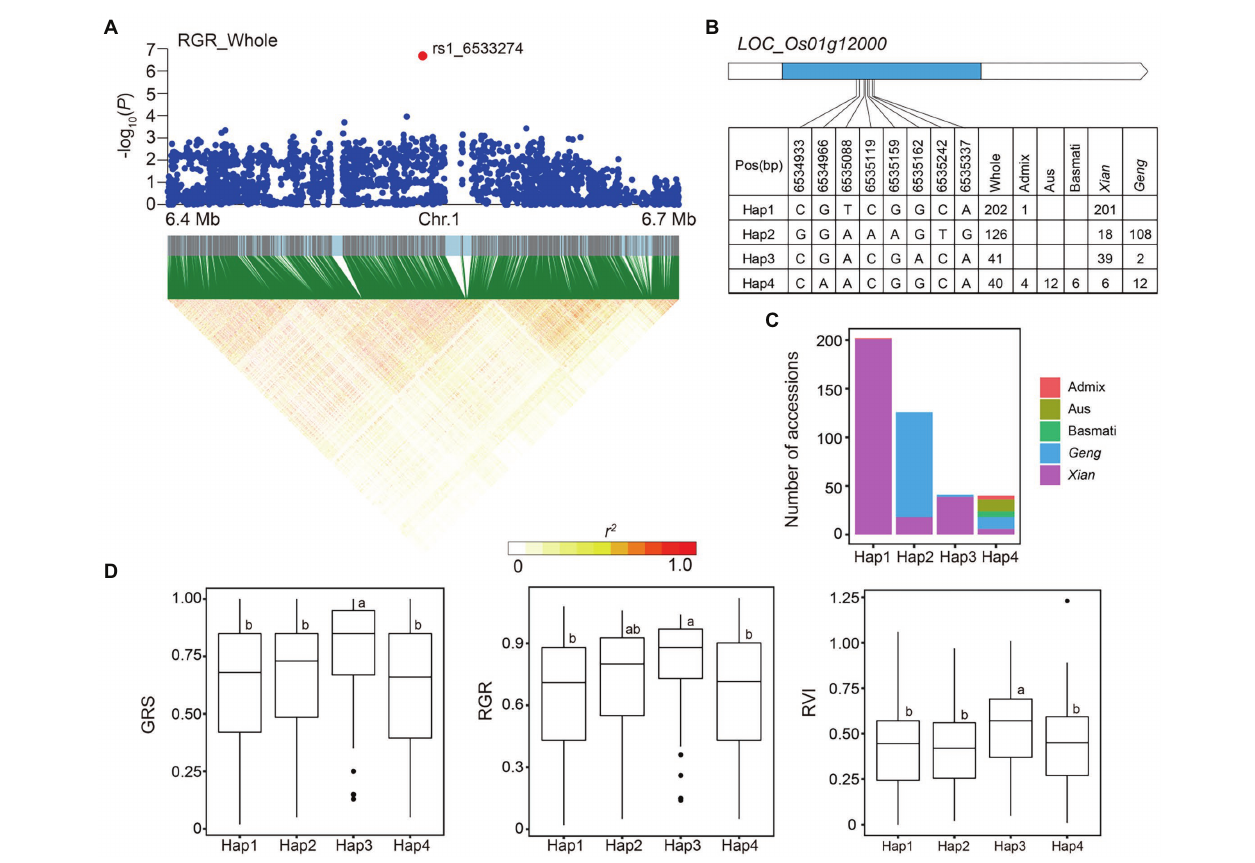
FIGURE 6 | Candidate gene analysis of locus 7 on chromosome 1. (A) Local Manhattan plot (top) and LD heat map (bottom) of locus 7 for RGR in the whole population. The red dot indicates the lead SNP rs1_6533274 and the position of candidate gene LOC_Os01g12000 . (B) CDS-haplotypes of LOC_Os01g12000 . (C) Frequency of four haplotypes of LOC_Os01g12000 in subpopulations. (D) The distribution of GRS, RGR, and RVI in the whole population for the four haplotypes of LOC_Os01g12000 . Different letters above each boxplot indicate significant differences among haplotypes according to Duncan’s multiple range post-hoc test ( p <